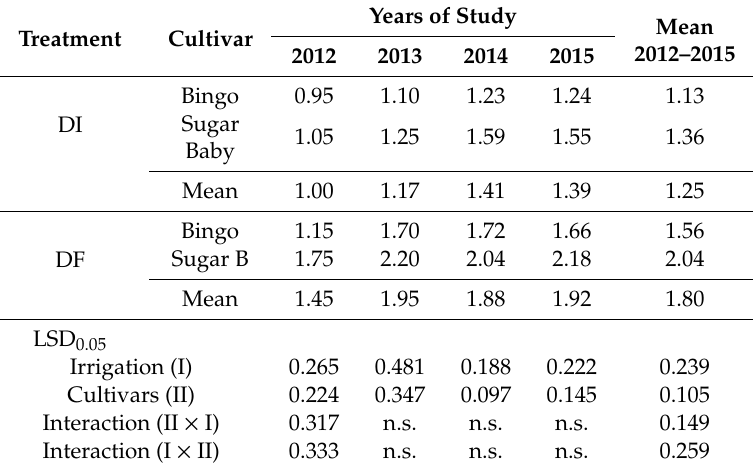
Table 6. Influence of nitrogen fertigation on the number of fruits of two watermelon cultivars: Bingo and Sugar Baby (pcs plant − 1